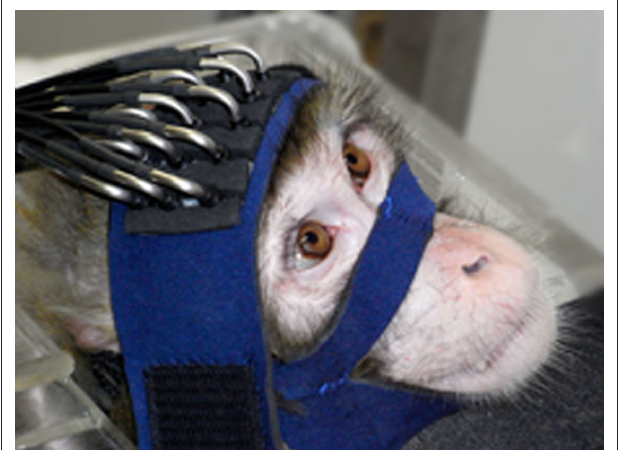
Figure 1 | The subject monkey with the NirS probe. The NIRS probe was fixed to the head by a flexible band for the frontal measurement. The inter-optode distance was 1